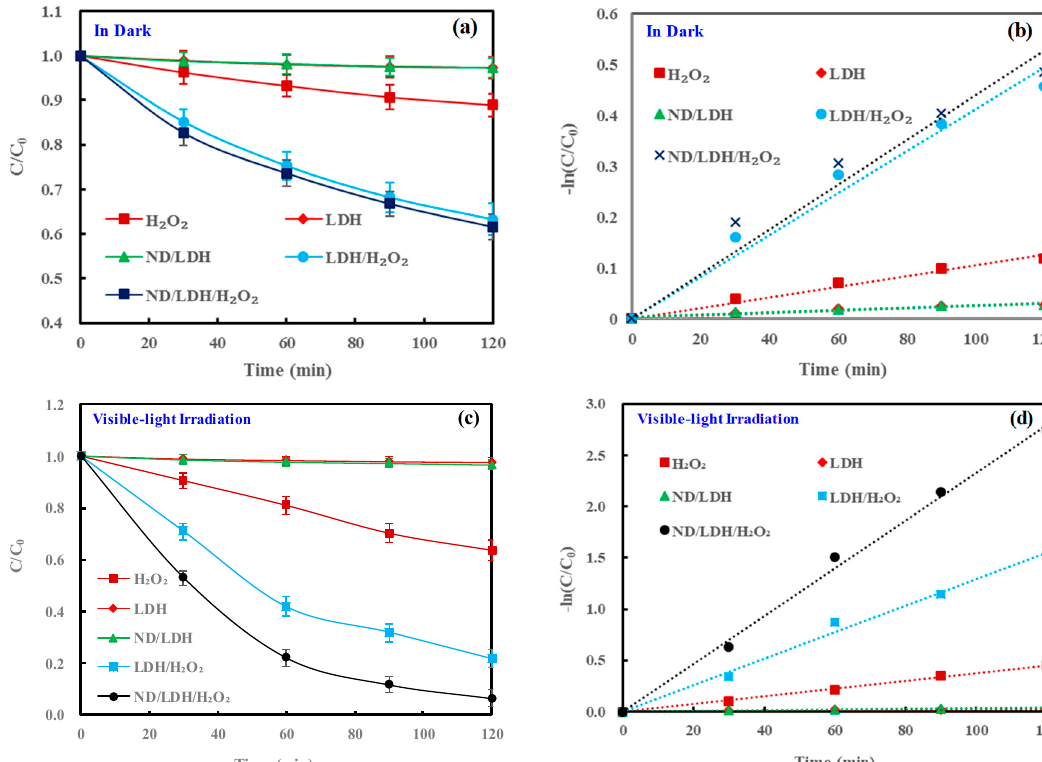
Figure 6. ( a ) Degradation of methylene blue (MB) in darkness; ( b ) pseudo-first-order kinetic fit for MB degradation in darkness; ( c ) photocatalytic degradation of MB under visible-light irradiation; and ( d ), pseudo-first-order kinetic fit for MB photodegradation under visible-light irradiation. (Error bars represent standard deviation of triplicate runs).